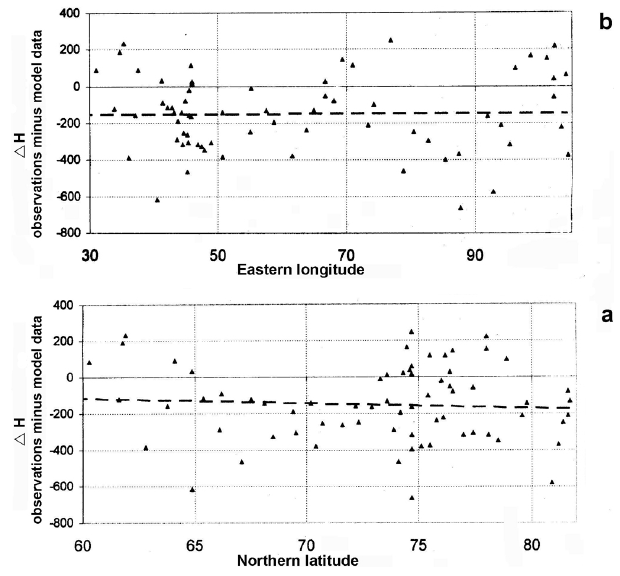
Figure 8. Di ff erences between ∆ H observed on board the airship and calculated according to the IGRF-11 model for the epoch 1930 as functions of latitude (a) and longitude (b) of observation